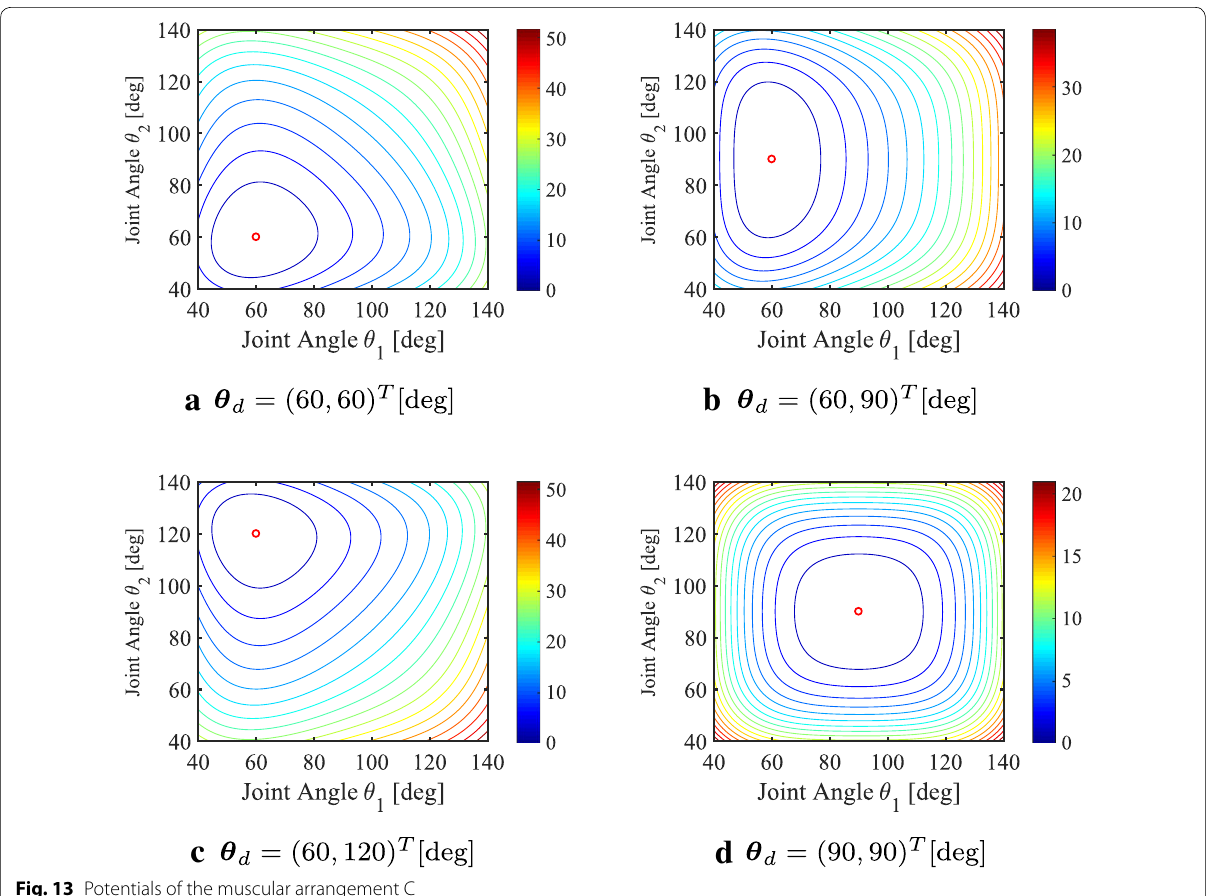
Fig. 13 Potentials of the muscular arrangement